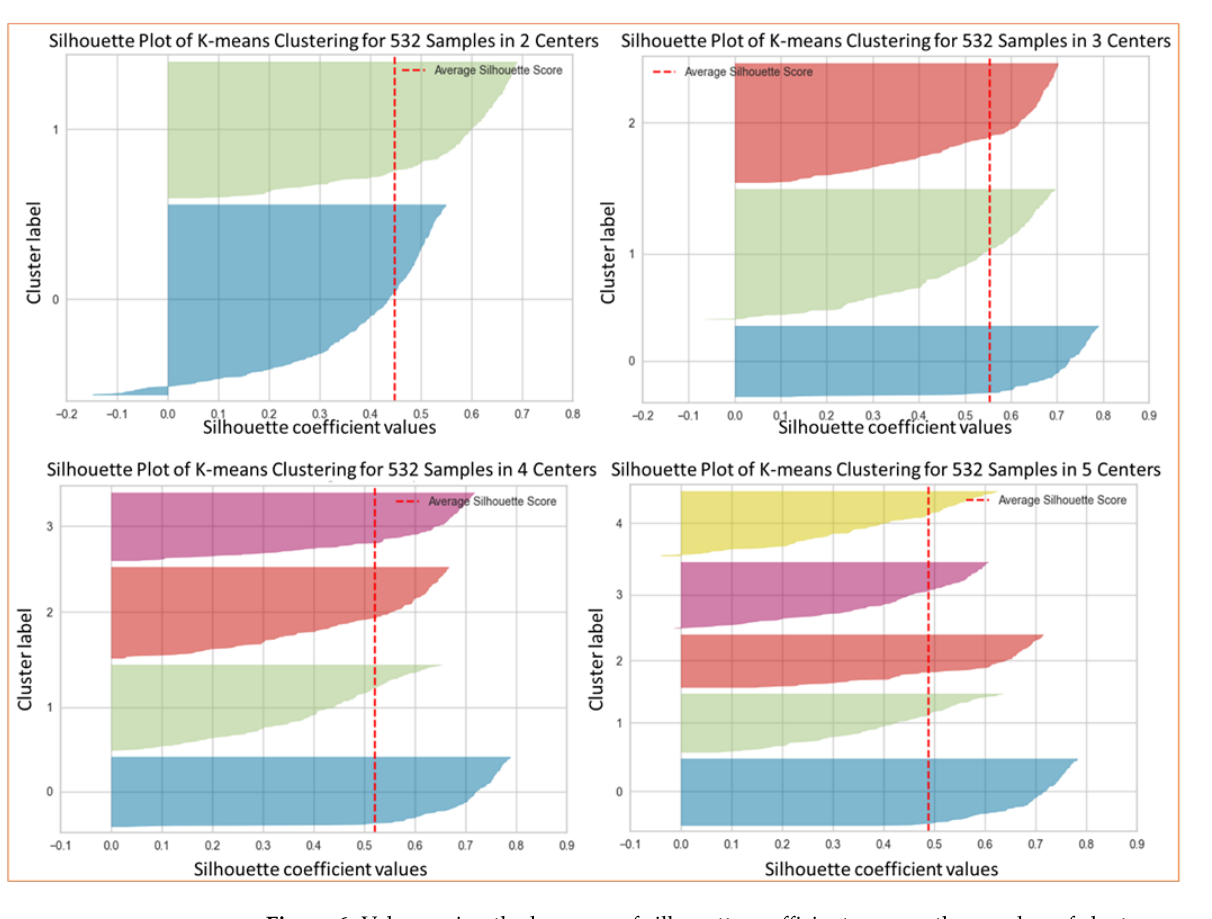
Figure 6. Values using the k-means of silhouette coefficients versus the number of clusters.